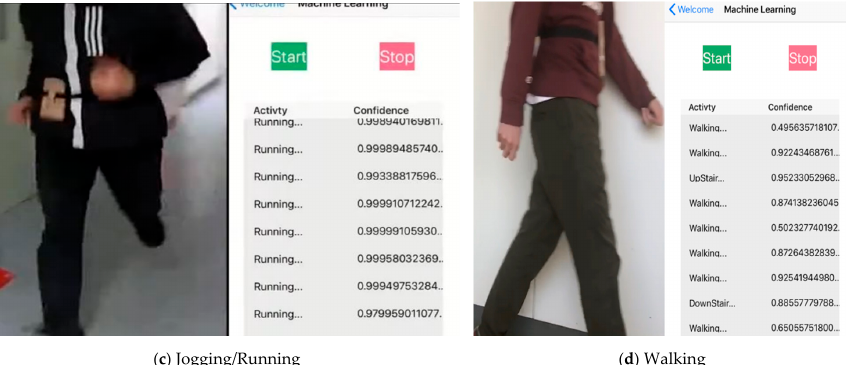
Figure 16. Real-time activity recognition by the iOS application.